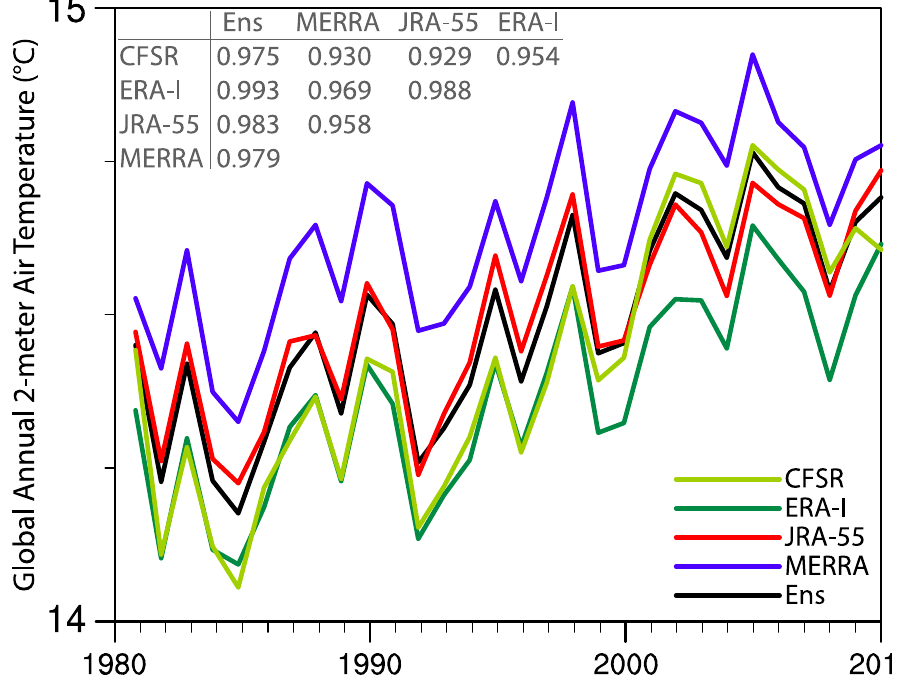
Figure 4. Global annual 2-m air temperature for each member and the ensemble mean (Ens) during 1981–2010. Correlation coefficients (r) for each time series shown in upper, left table.